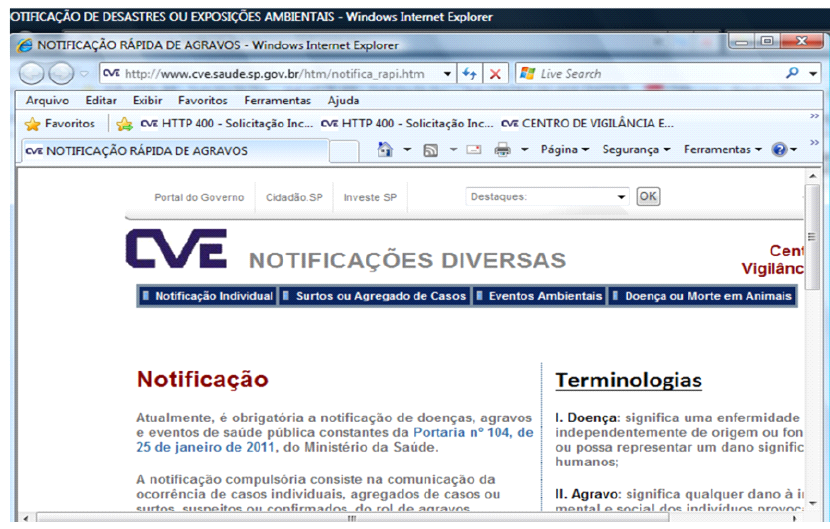
Figure 11. The NOTIFICA ONLINE system.